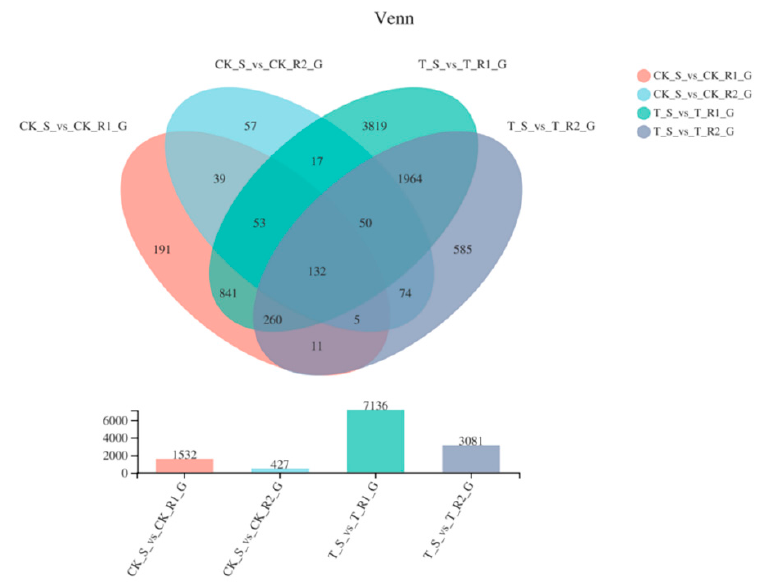
Figure 3. Venn diagram showing the number of DEGs in four samples.